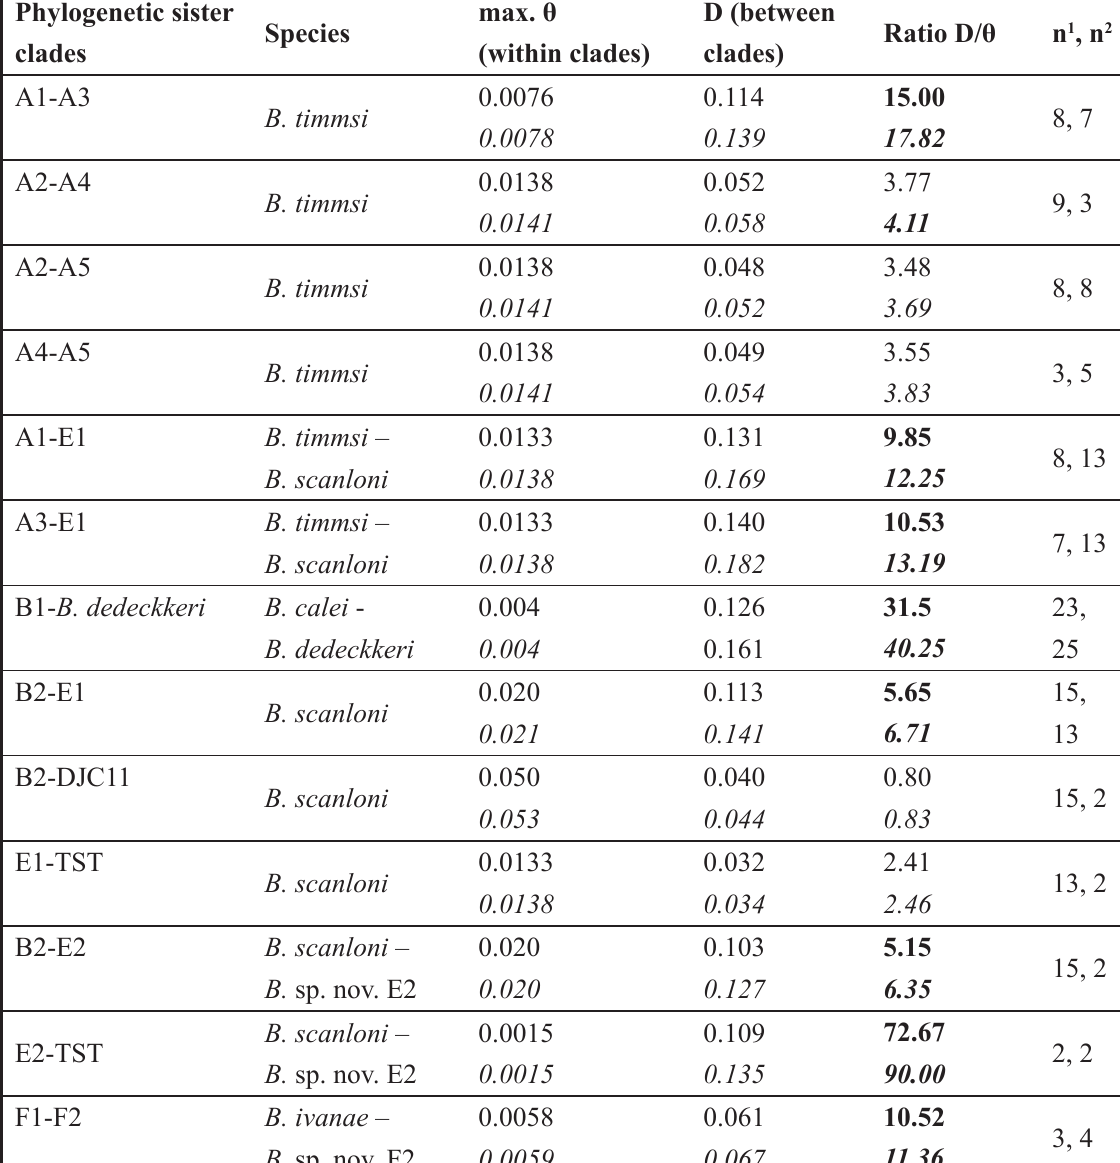
Table 2. results of tests for genetic species boundaries using the 4 theta method for six species of the Bennelongia barangaroo